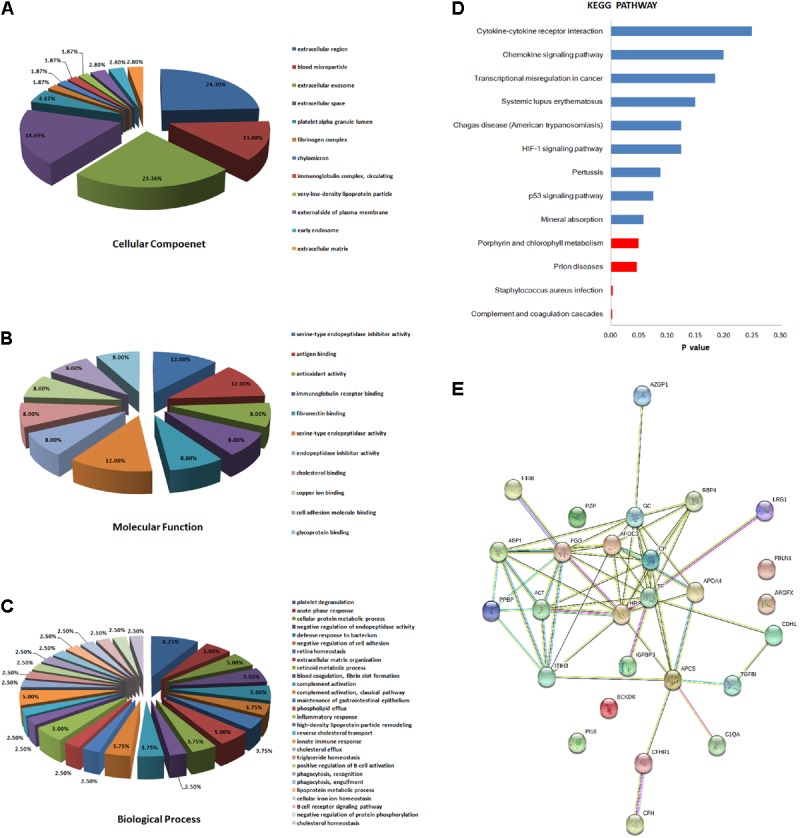
Bioinformatics analysis of the differentially expressed proteins. (A) Cellular component (GO analysis); (B) molecular function (GO analysis); (C) biological process (GO analysis); (D) KEGG pathway analysis; (E) function network analysis of differentially expressed proteins using STRING software.